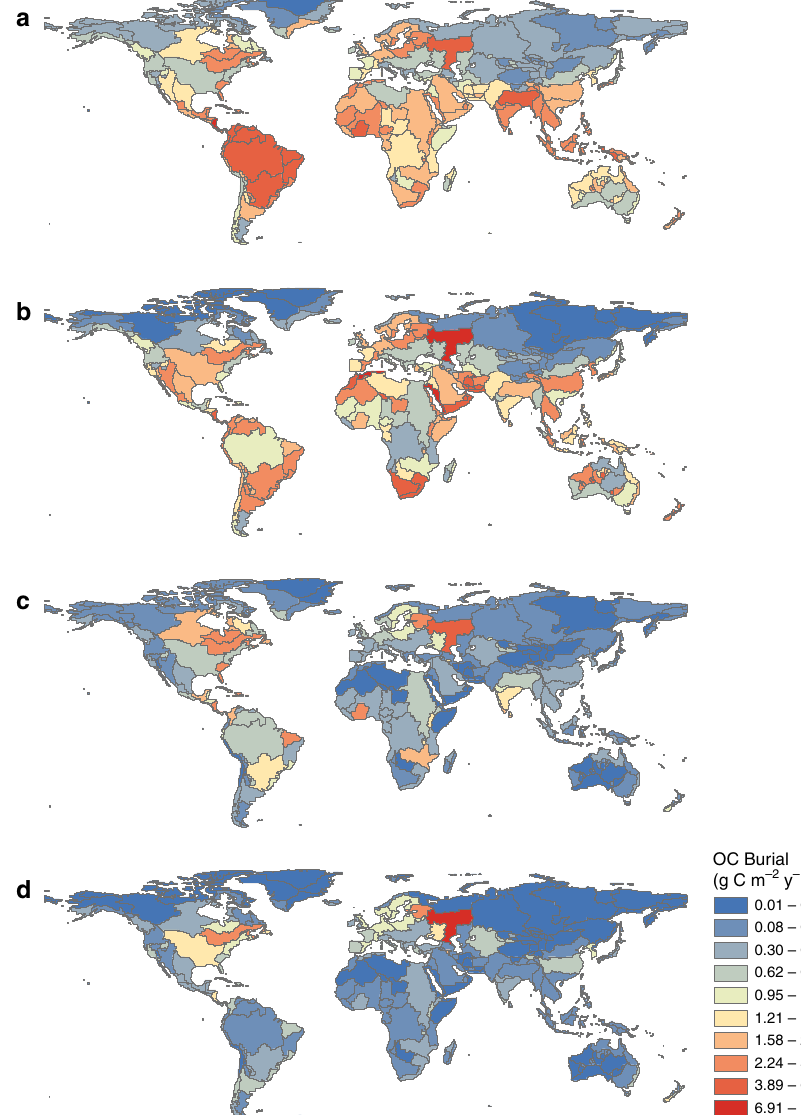
Fig. 2 Organic carbon burial rate per total COSCAT area. The rates were calculated by dividing the total organic carbon burial in a COSCAT, in g C per year, per the total COSCAT area. a Scenario AG, one model for all data, GLOWABO 20 areas; b scenario SG, model for cold COSCATs, average burial for warm COSCATs, GLOWABO areas; c scenario AR, one model for all data, Raymond et al. 15 areas; d scenario SR, model for cold COSCATs, average burial